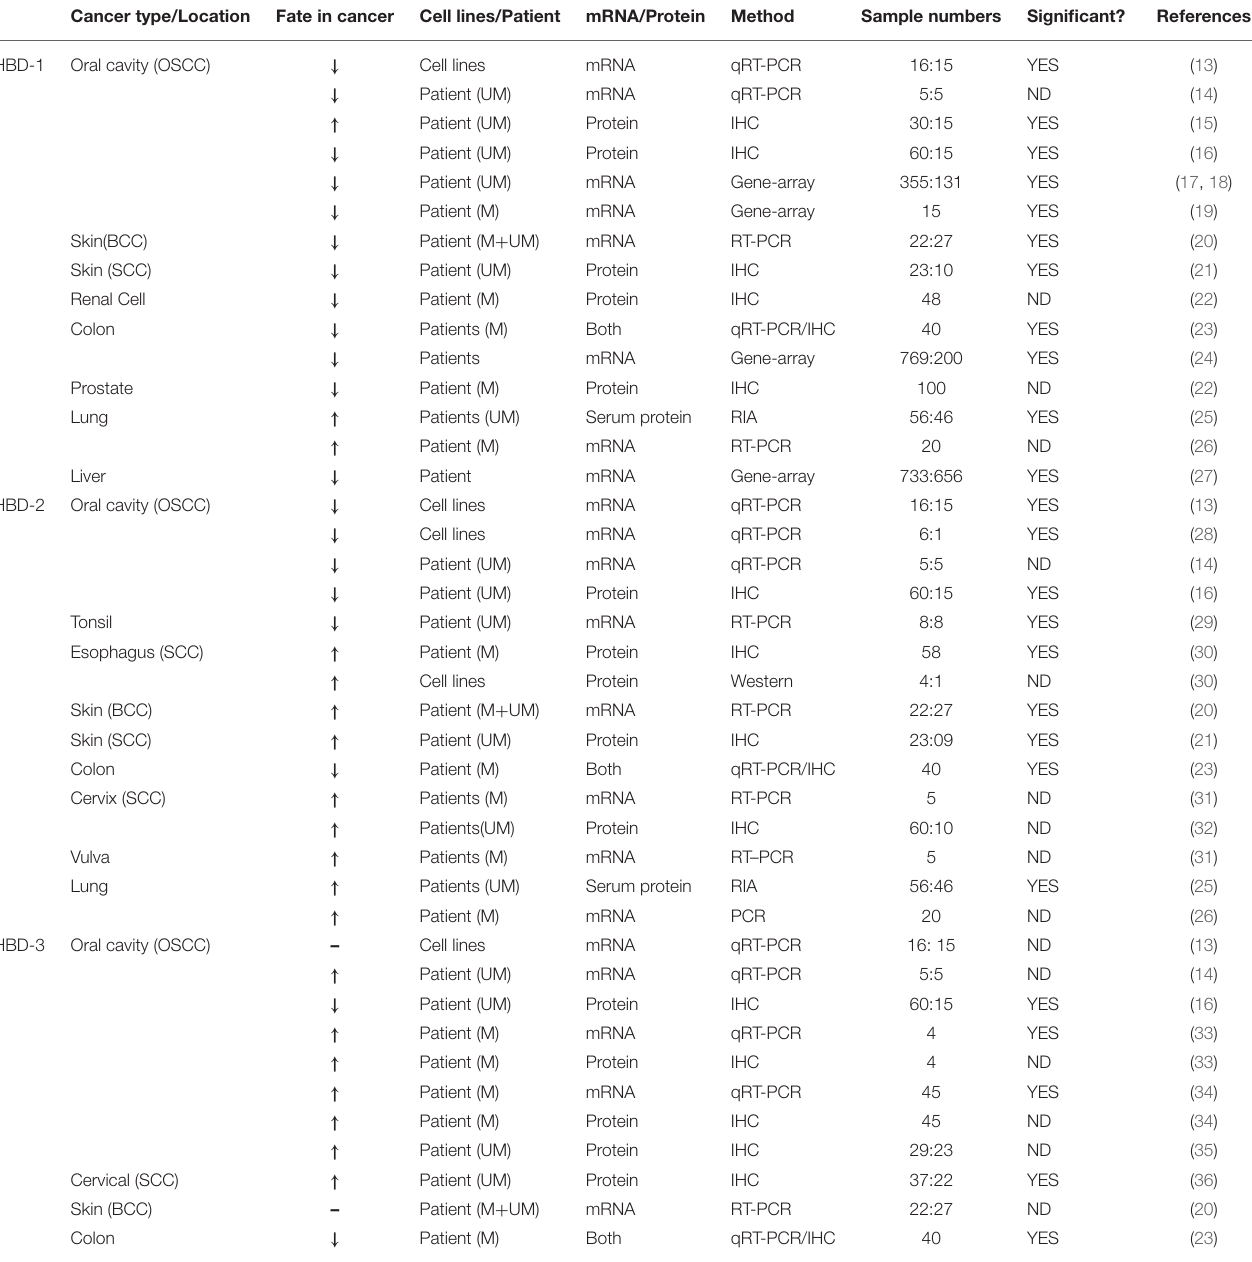
TABLE 1 | Studies related to differential expression of hBDs (1, 2, and − 3) in cancer. Cancer